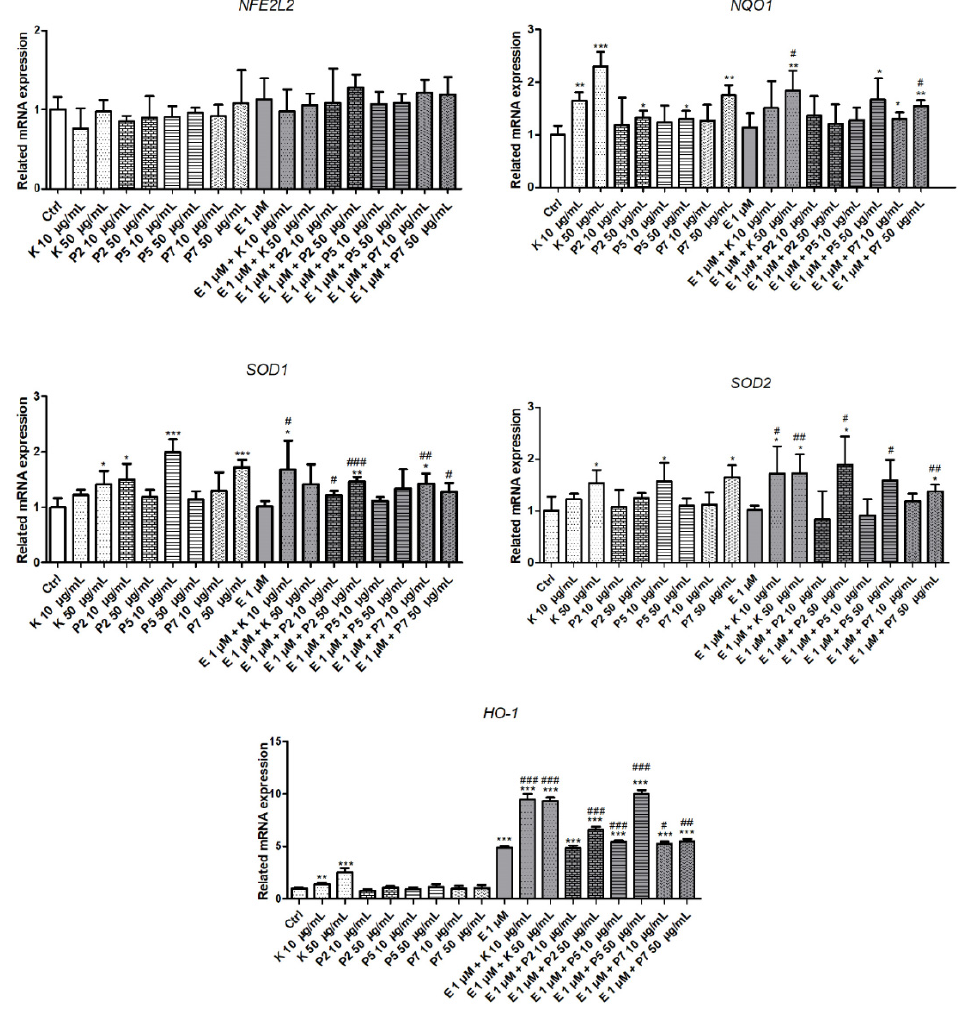
Figure 1. Relative expression of the NFE2L2 , NQO1 , SOD1 , SOD2 , and HO-1 genes in HL-60 cells incubated for 24 h at 37 ° C with 10–50-µg/mL kaempferol (K), P2, P5, P7, and/or 1-µM etoposide (E). The figure shows the mean results ± SD, n = 4; * p < 0.05, ** p < 0.01, and *** p < 0.001 vs. control (Ctrl); # p < 0.05, ## p < 0.01, and ### p < 0.001 vs. etoposide (E).